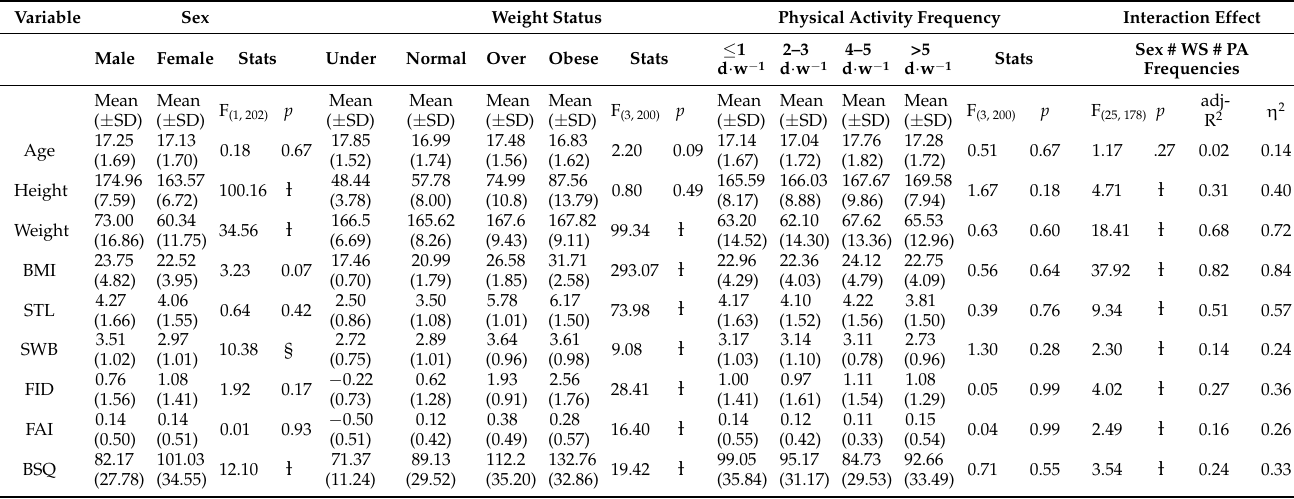
Table 2. Mean comparisons and interaction effects between sex, weight status, and physical activity frequency.